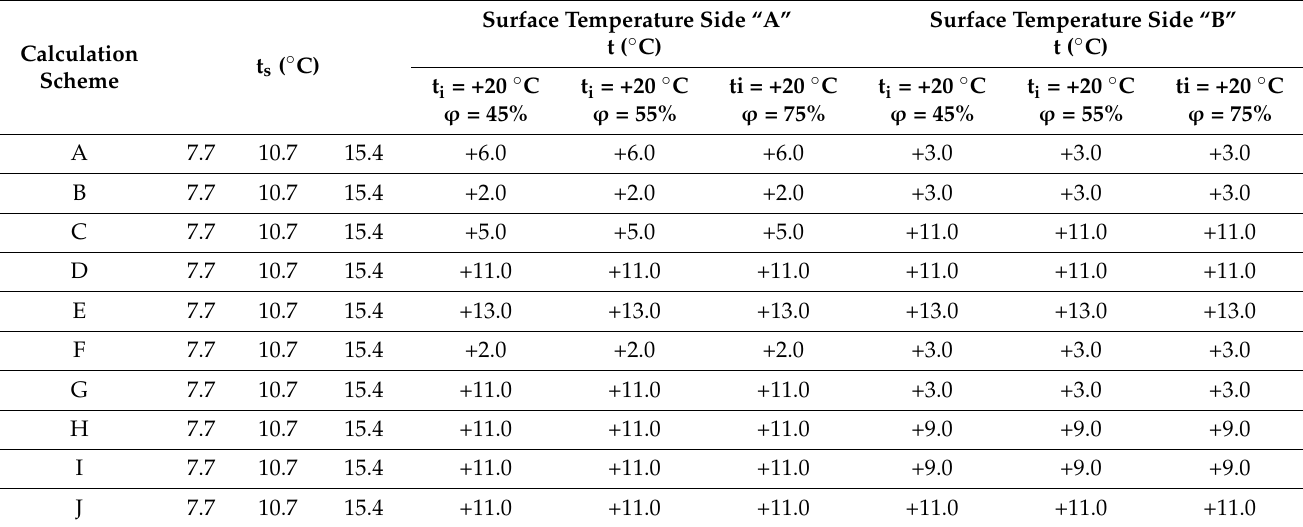
Table 2. Temperature comparison for t i = +20 ◦ C and different ϕ from 45% to